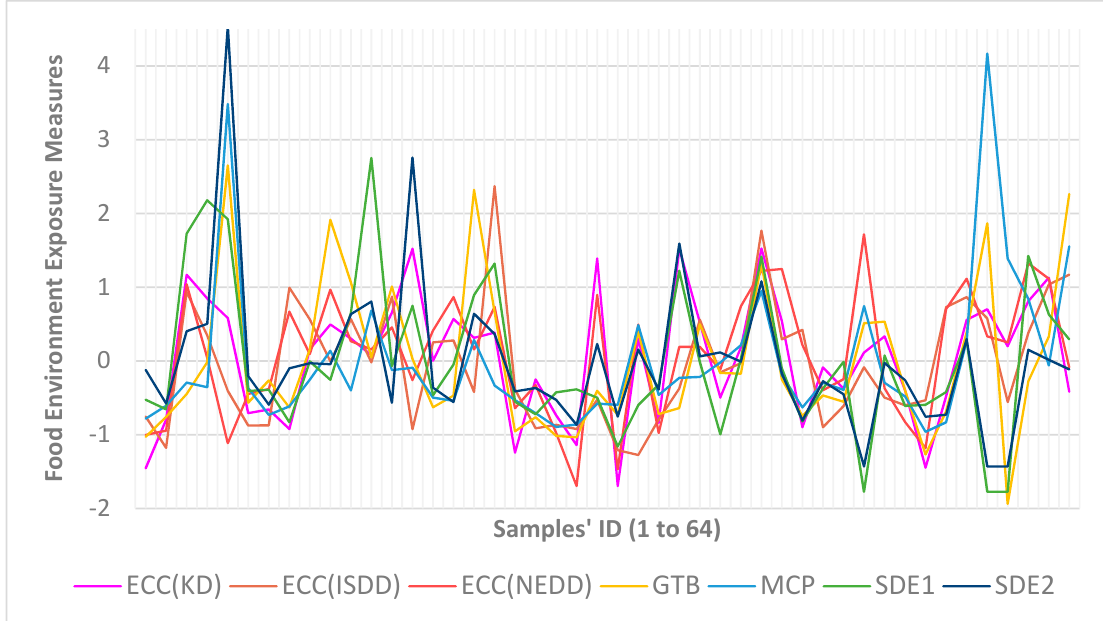
Figure 9. Comparison of the exposure measures obtained with different methods for each participant. (ECC: environmental context cube; KD: kernel density estimation; ISDD: inverse-square distance decay function; NEDD: negative-exponent distance decay function; GTB: GPS trajectory buffers; MCP: minimum convex polygons; SDE1: standard deviation ellipses with one standard deviation; SDE2: standard deviation ellipses with two standard deviations.)